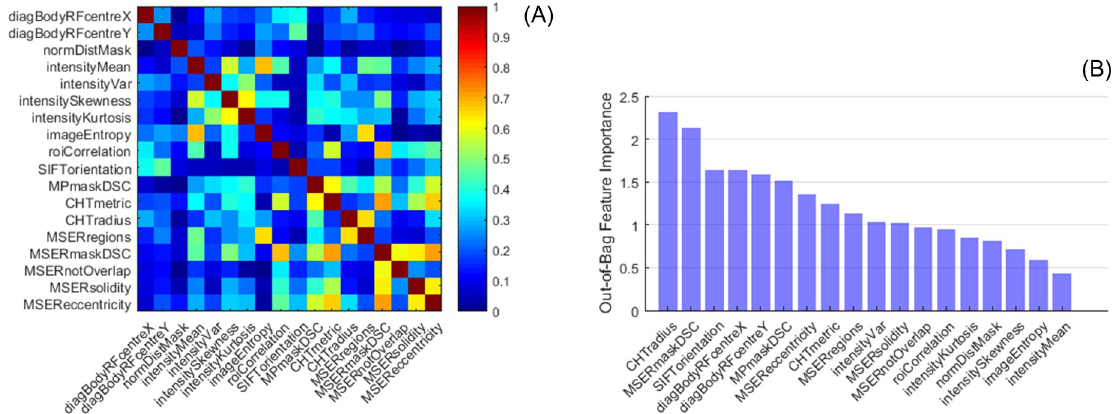
Fig 6. Absolute correlation between pairs of image features (A) and relative importance (B). Calculated from out-of-bag (OOB) observations in the training dataset (1200 scans in total).